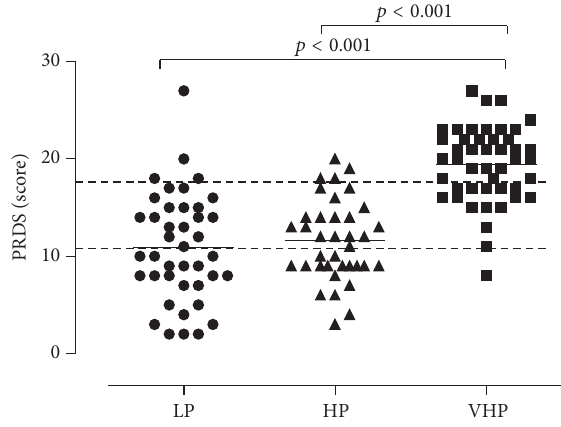
Figure 1: PRDS score, calculated on single report at the time of outpatients visit. Median value indicates the score to be given to the specialist’s prescription for low priority (LP, circles, 𝑛 = 41 ); high priority (HP, triangles, 𝑛 = 37 ); and very high priority (VHP, squares, 𝑛 = 46 ). Dotted lines at 11 and 18 delimit the arbitrary cut-offs of PR priority, that is, for LP (0–10), HP (11–17), and VHP (18–34). One-way ANOVA was performed to compare differences among settings and, where significant, Bonferroni’s multiple comparison was applied as post hoc test. A 𝑝 value < 0.05 was considered statistically significant.